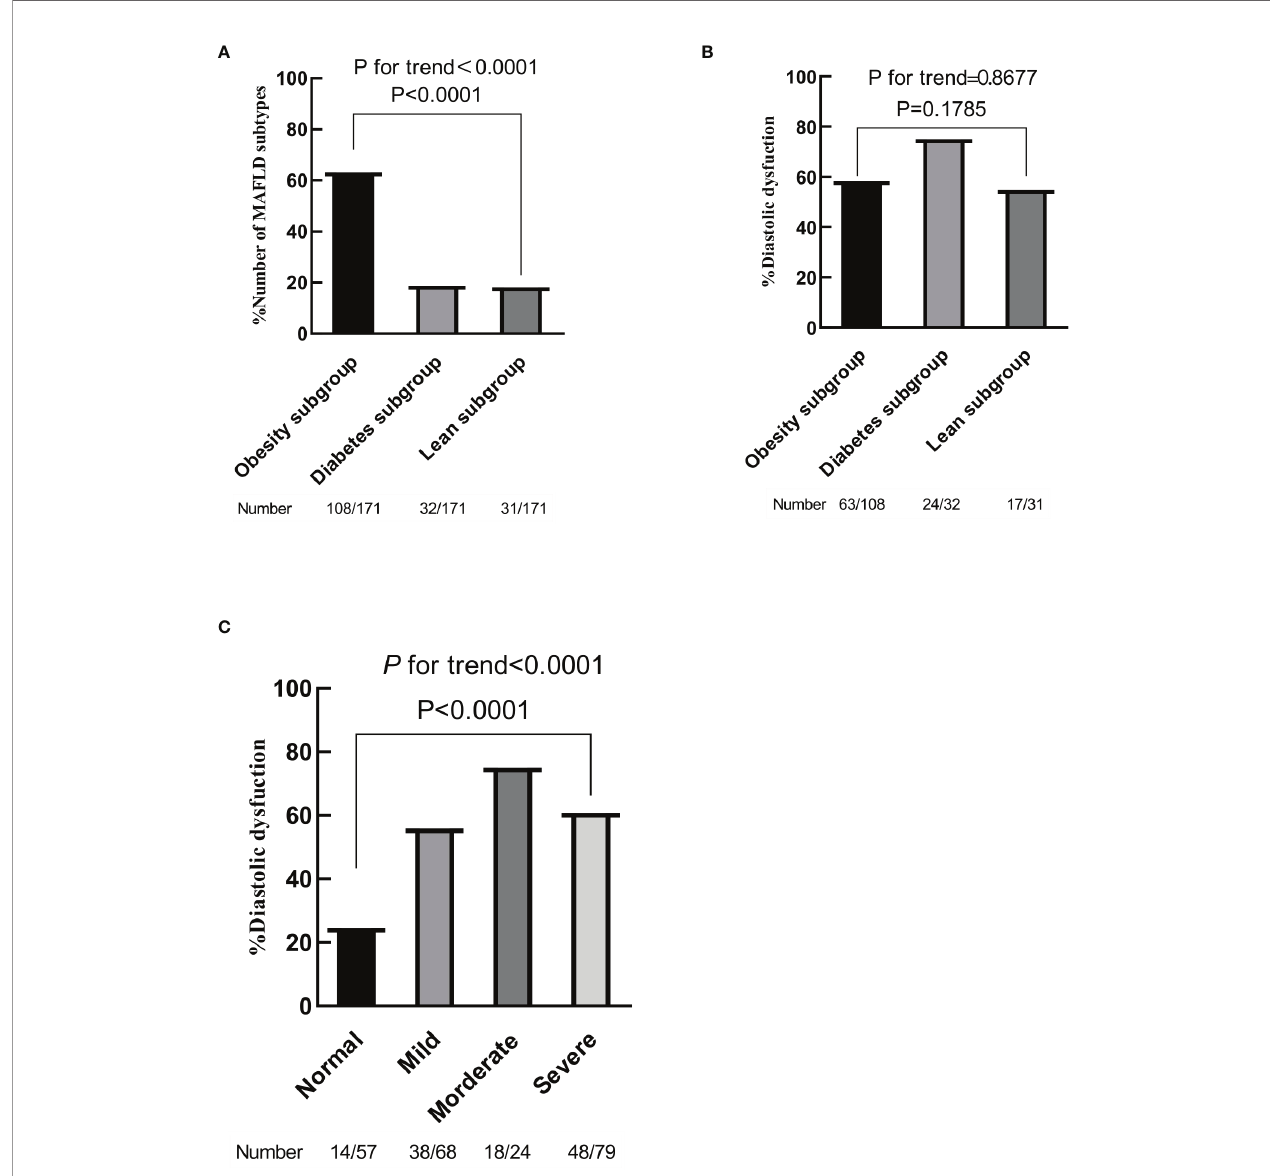
FIGURE 2 | Prevalence of different metabolic dysfunction-associated fatty liver disease (MAFLD) subgroups (A) . Prevalence of left ventricular diastolic dysfunction according to MAFLD subtypes (B) . Prevalence of left ventricular diastolic dysfunction according to the degree of hepatic steatosis (C) . p for trend by chi-square test for linear-by-linear